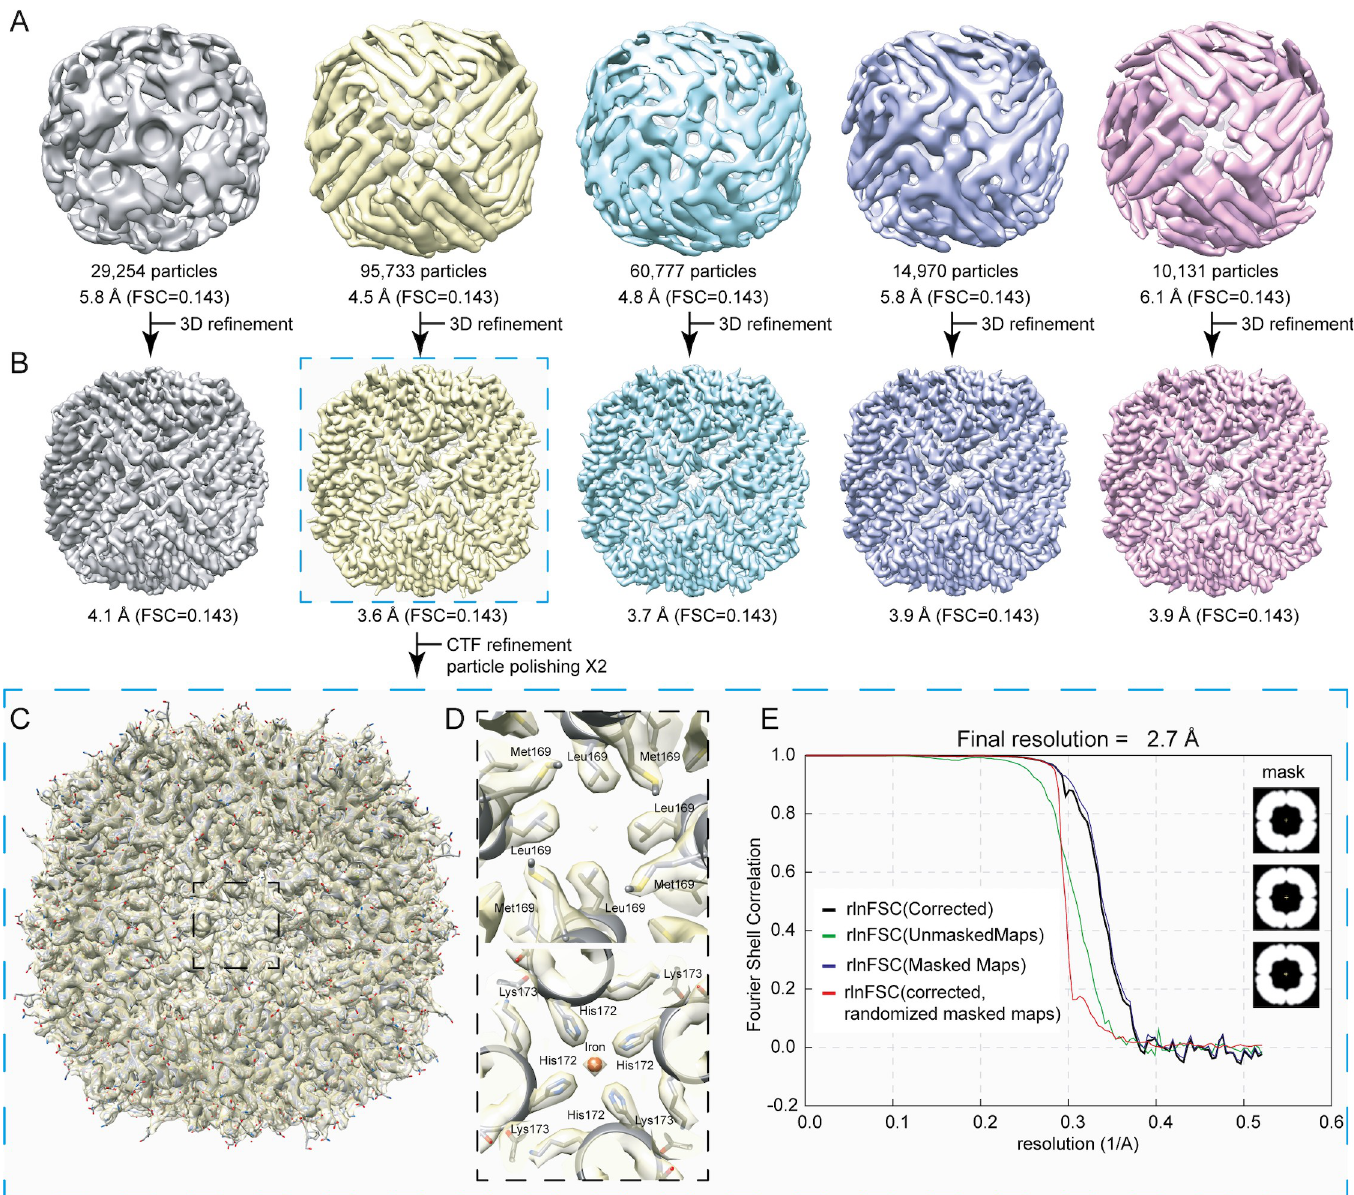
Fig 3. Image processing of single-particle data after 2D classification and final resolution estimation. (A) Five (5) 3D classes were initially calculated, reaching resolutions from 4.5 Å to 6.1 Å . (B) Subsequent 3D refinement procedures led to reconstructions of the classes in a resolution range of 3.6 Å to 4.1 Å . (C) Overlap of the final atomic model of mouse apoferritin with the refined Coulomb potential density map. (D) Close-up images along the 4-fold axis of apoferritin at different depths of the protein shell. Coulomb potential densities are recapitulated for the corresponding channel, including a bound iron atom. (E) Fourier shell correlation plot for the final 3D reconstruction shown in (C). At an FSC of a reported correlation value of 0.143, resolution reaches 2.7 Å .